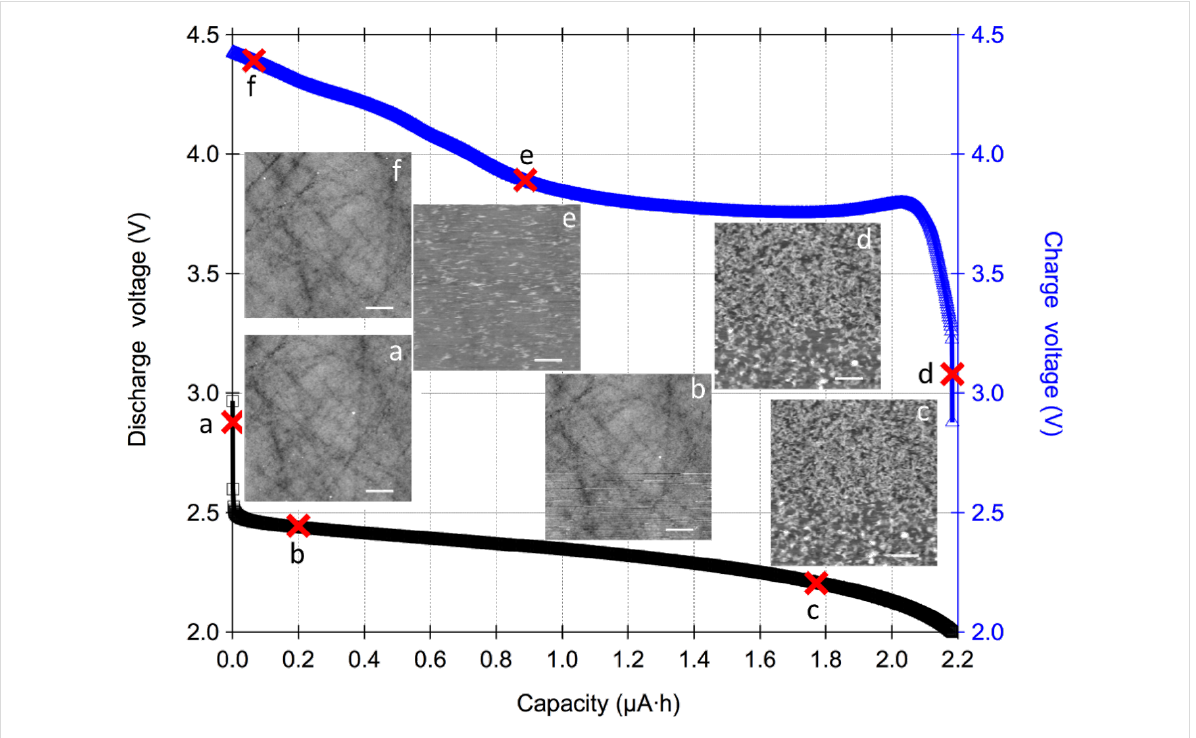
Figure 3: Electrochemical discharge (black, left y -axis) and recharge (blue, right y -axis) curves with topography images from simultaneous AFM scans. The X marks on the curves denote the discharge or recharge capacity at the end of the AFM scan. The AFM images (3 × 3 µm) were collected in 1 M LiNO 3 in TEGDME with <20 ppm of water in the electrolyte from one of the nine spiral spots as shown in Figure 1. The discharge current was 5 µA. Electrochemical deposits appear to nucleate, grow and then eventually shrink on the glassy carbon surface as the cell goes through discharge and recharge. The Z scale for Figure 3a, 3b, 3e and 3f is 20 nm and 80 nm for Figure 3c and 3d; the horizontal scale bar is 500 nm. 63 images in total are collectively presented in Movie 1 (Supporting Information File 2) for time domain visualizations of all the nine areas scanned on the